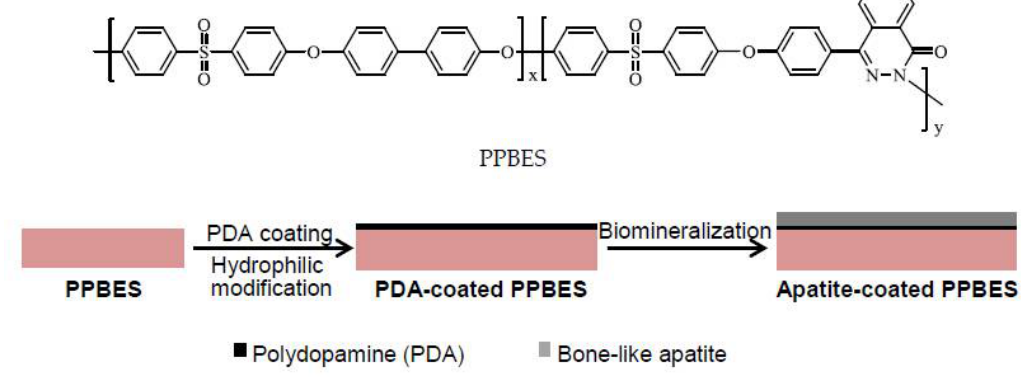
Figure 1. Chemical structure of Copoly(phthalazinone biphenyl ether sulfone) (PPBES) and schematic illustration of dopamine polymerisation and apatite biomineralisation on PPBES.